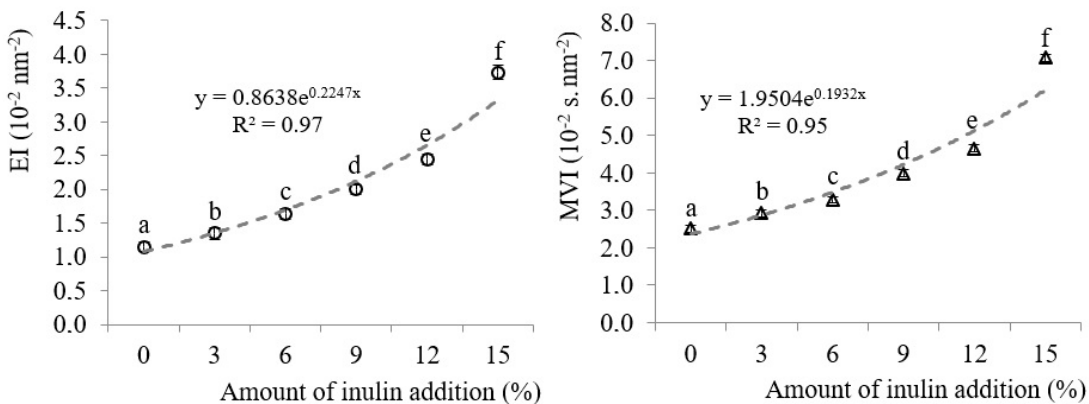
Figure 4. Elasticity indexes (EIs) and macroscopic viscosity indexes (MVIs) of yogurts with 0%, 3%, 6%, 9%, 12% or 15% w/w inulin addition (a, b, c…—various letters for average values mean statistically significant differences, p < 0.05).